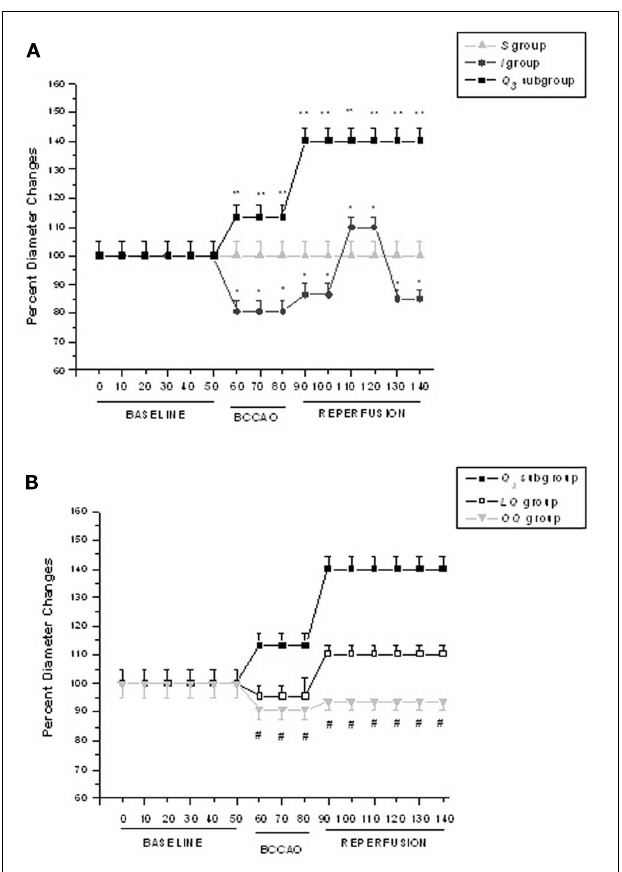
FIGURE 2 |Time course plots of diameter changes in the experimental groups. (A) Diameter changes of order 2 arterioles, expressed as percent of baseline, under baseline conditions, during BCCAO and reperfusion in S = sham-operated group, I = ischemic group, and in Q 3 = quercetin (5.0mg/kg b.w.) subgroup; (B) Diameter changes of order 2 arterioles, expressed as percent of baseline, under baseline conditions, during BCCAO and reperfusion in Q 3 = quercetin (5.0mg/kg b.w.) subgroup, LQ = L-NAME + quercetin (5.0mg/kg b.w.) group, OQ = 1H-(1, 2, 4) oxadiazolo (4, 3-alpha) quinoxalin-1-one (ODQ) + quercetin (5.0mg/kg b.w.) group.˚ p < 0.01 vs. baseline; * p < 0.01 vs. I group; # p < 0.01 vs. Q 3 subgroup.